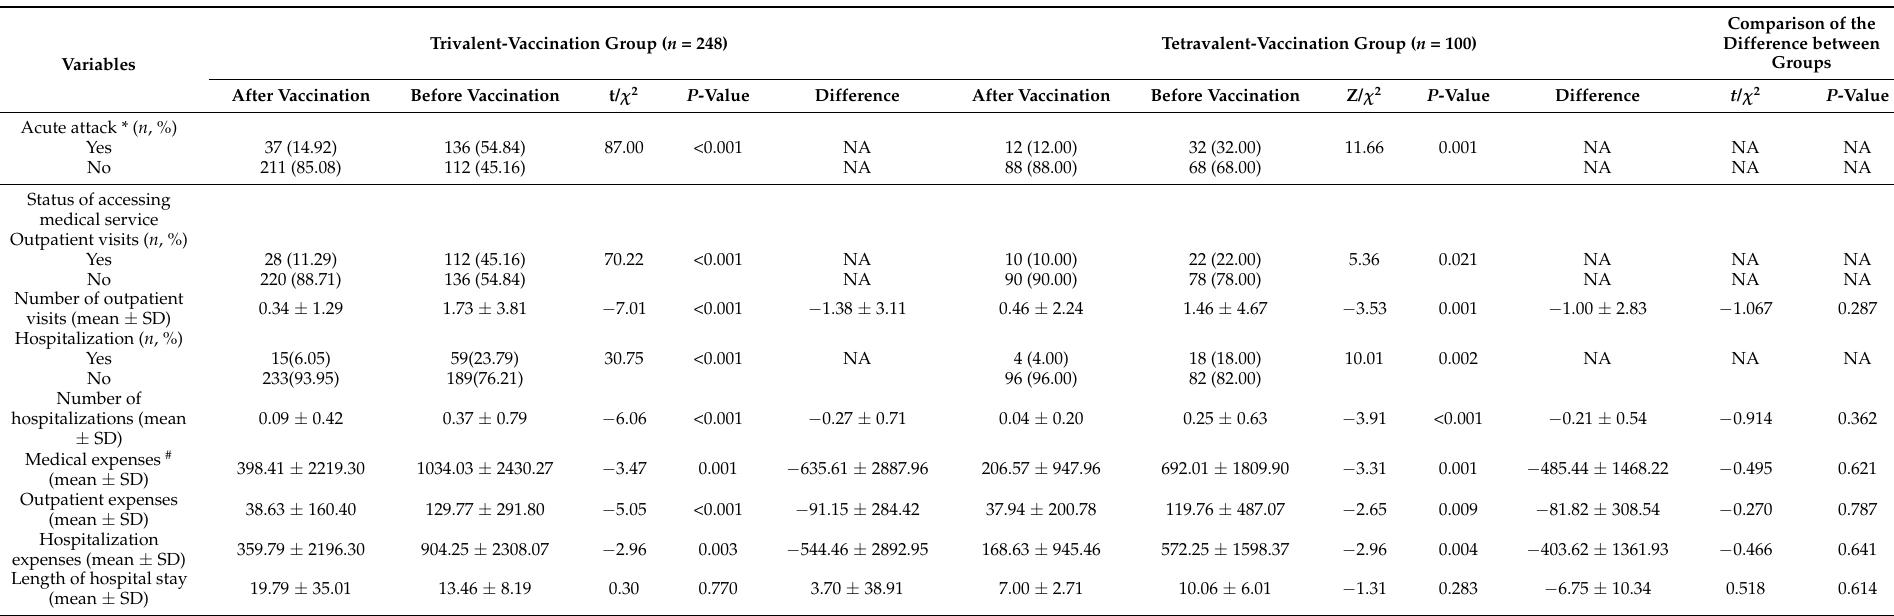
Comparison of the Difference between Groups